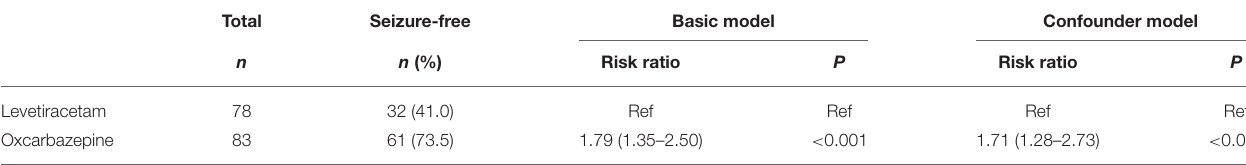
TABLE 2 | Generalized linear regression models evaluating the association between treatment and seizure outcome ( n =